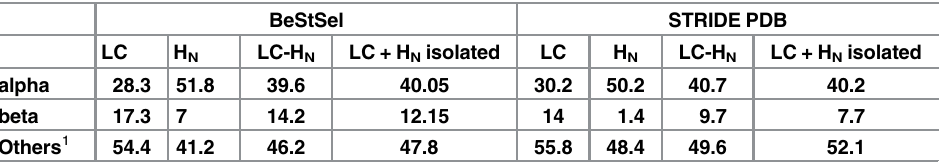
Table 1. Comparison of the secondary structure of the three proteins based on the far-UV CD spectra at pH 7 (BeStSel [46]) with the secondary structure observed in the crystal structure of BoNT/A (3BTA) (STRIDE